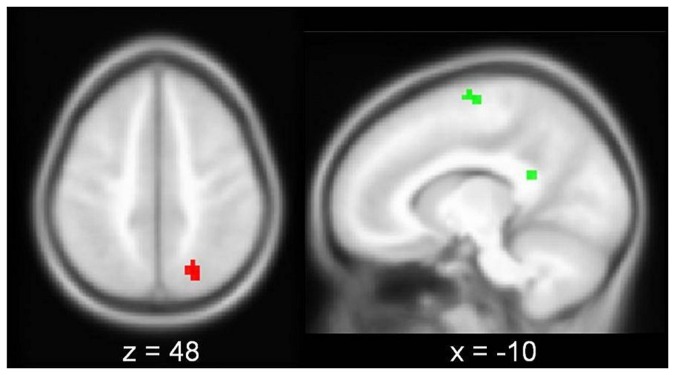
Performance-related activation increases within (red) and decreases outside (green) the global task-related network (GlobalFWE) overlaid on sections (MNI coordinate of slice) of the custom group T1 template.All clusters within ROIs at uncorrected p < .001 and extent threshold k > 15.